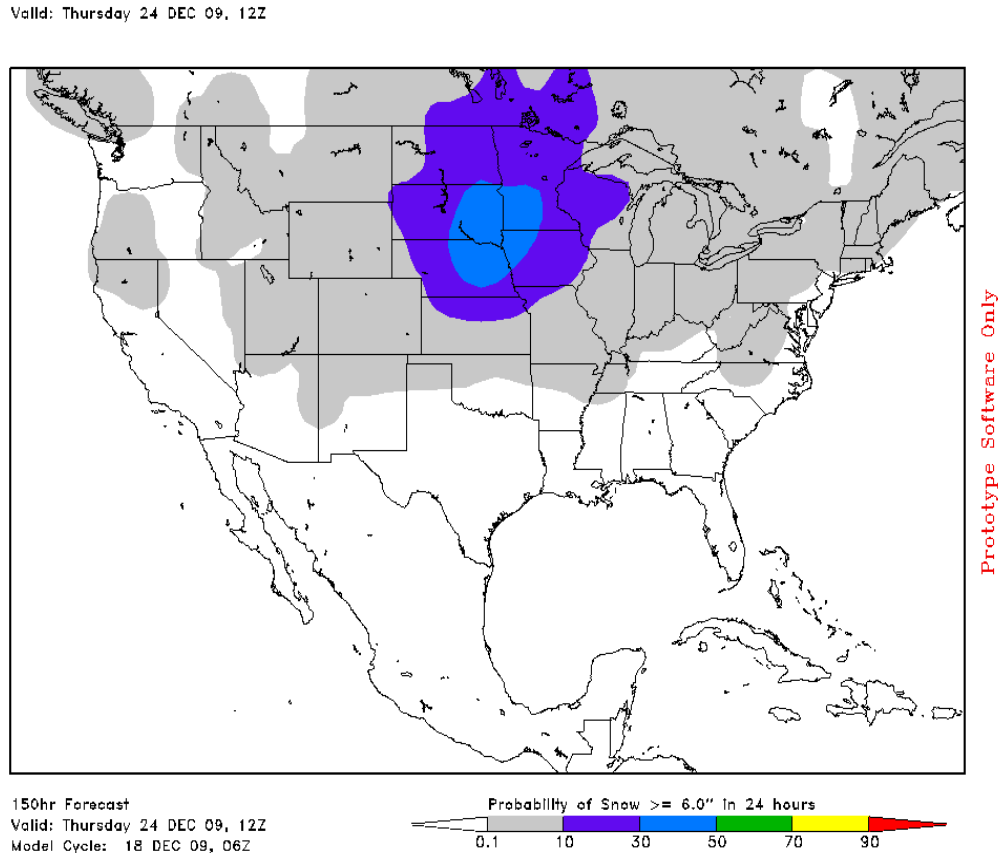
Figure 5. 150-hour global ensemble probability (percent) forecast of snow exceeding 6 inches (15.24 cm) for the 24 hours preceding 1200 UTC on 24 Dec 2009.